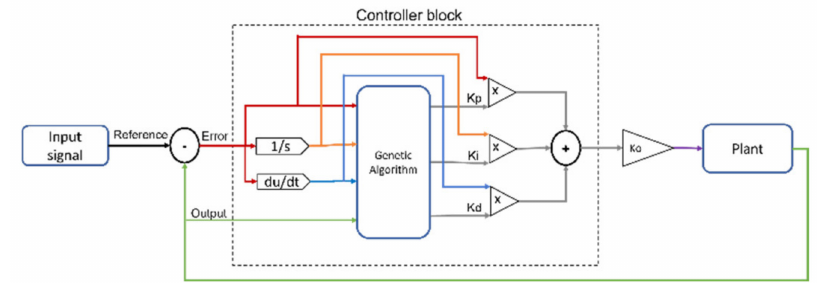
Figure 10. Autotuned